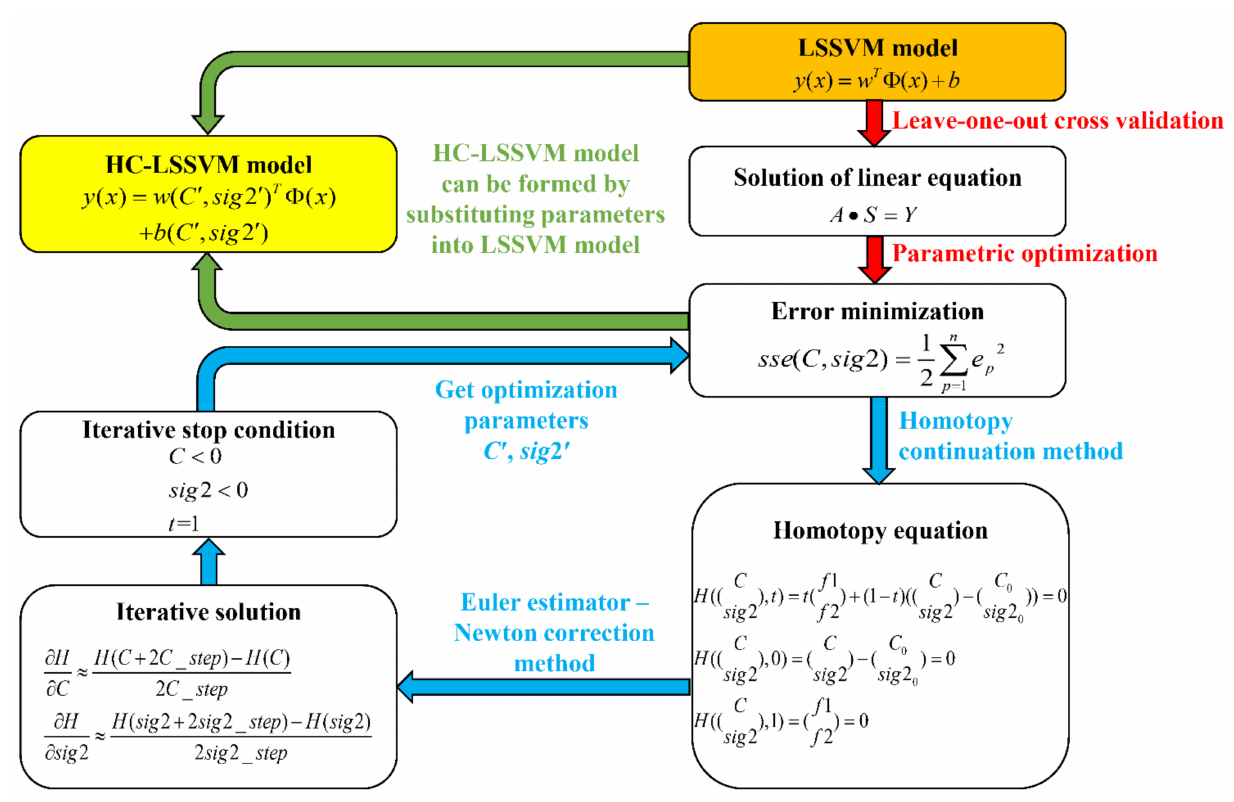
Figure 2. Block diagram of HC-LSSVM model for soft soil settlement prediction. The orange box is the starting position of the block diagram, and the yellow box is the end position of the block diagram. The arrows in different colors represent the sequence of the model building process, with the red sorted as 1, the light blue sorted as 2, and the green sorted as